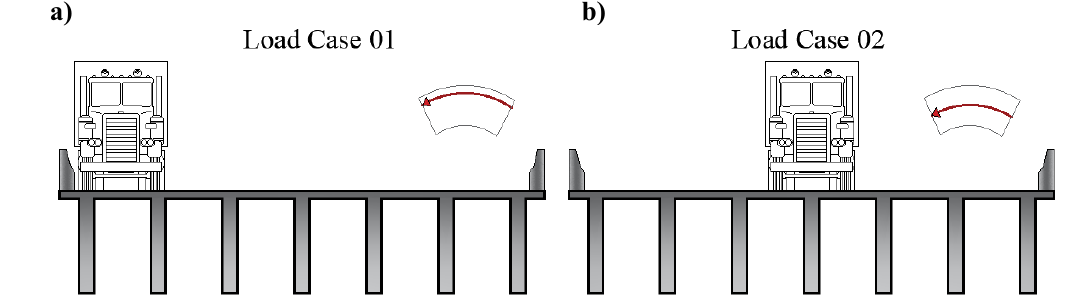
Figure 6. (a) Load case 01 – vehicle positioned at the outside of the curve. (b) Load case 02 – vehicle positioned at the curve